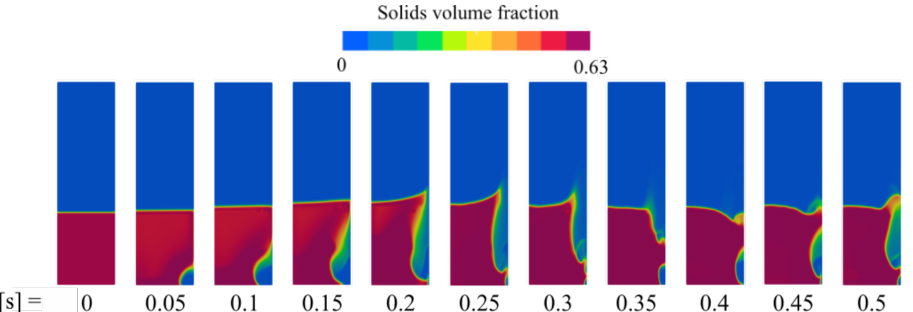
Figure 4. Solids volume fraction distribution at different times from the beginning of the fluidization using OpenFOAM.